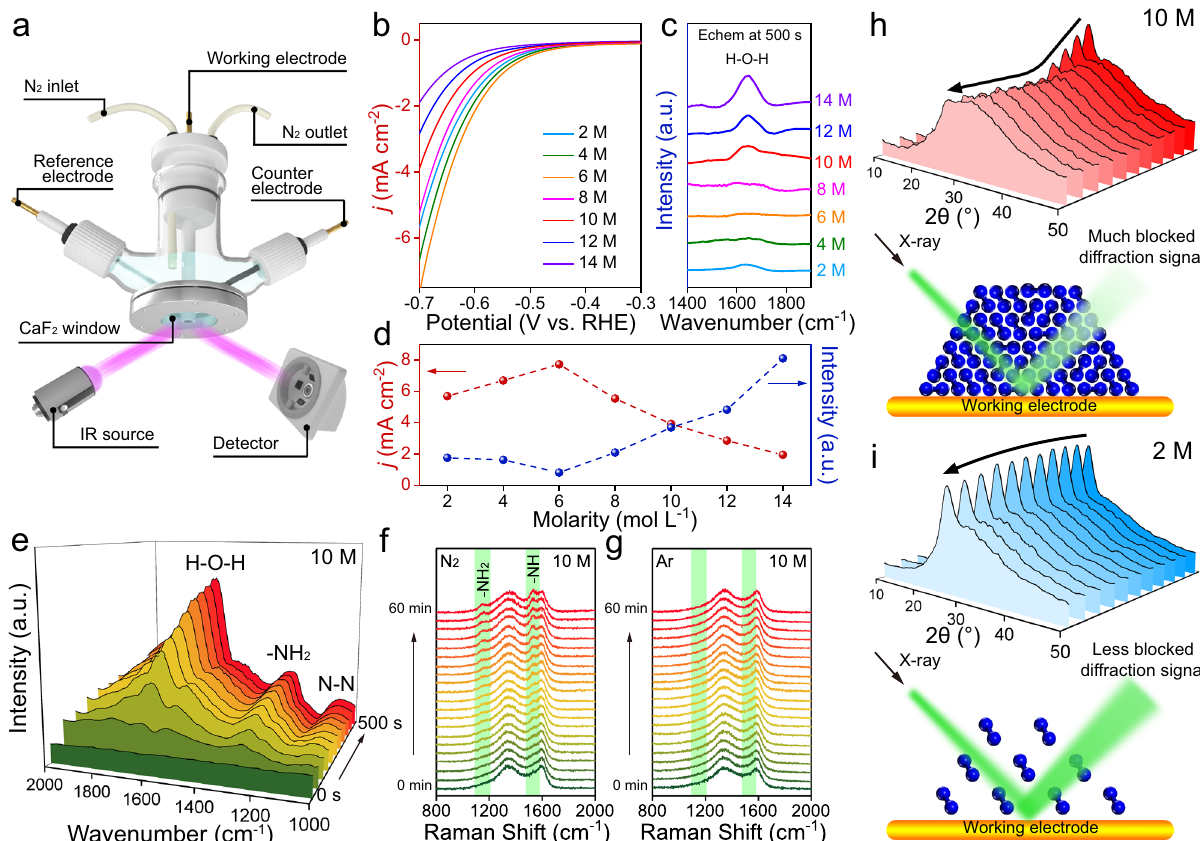
Fig. 3 HER performance and in situ characterization. a Schematic of the tailor-made electrolytic cell for in situ Fourier transform infrared (FTIR) characterization. b Linear sweep voltammetry (LSV) curves of different systems under an Ar-saturated environment. c In situ FTIR spectra captured under electrochemical (Echem) reaction conditions at − 0.3V vs. RHE at 500 s. a.u., arbitrary units. d Comparison of the hydrogen evolution reaction (HER) activities and intensities of the H-O-H bending vibration in the FTIR spectra as a function of salt concentration. e In situ FTIR spectra with 10M LiCl as the electrolyte at − 0.3 V vs. RHE as a function of time. In situ Raman spectra with f N − 0.3V vs. RHE as a function 2 -saturated and g Ar-saturated 10M LiCl as the electrolyte at of time. In situ X-ray diffraction (XRD) contour plots of working electrodes and the corresponding schematic of the mechanism with h 10M and i 2M LiCl as electrolytes during the nitrogen reduction reaction (NRR) process at − 0.3V vs. RHE as a function of